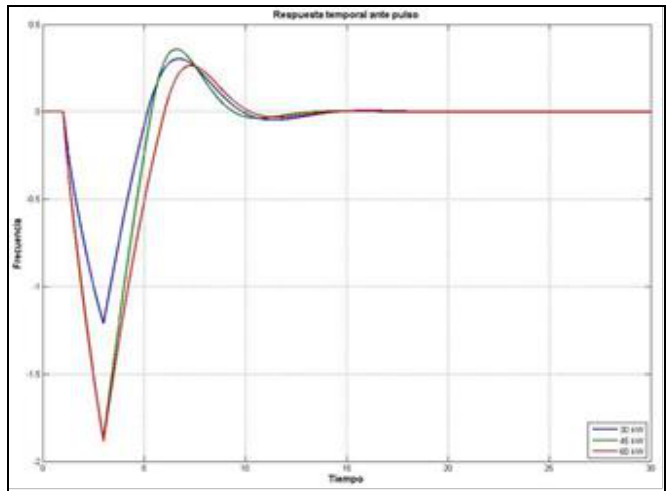
Figura 4: Respuesta temporal ante perturbación pulso. Fuente: Los Autores,